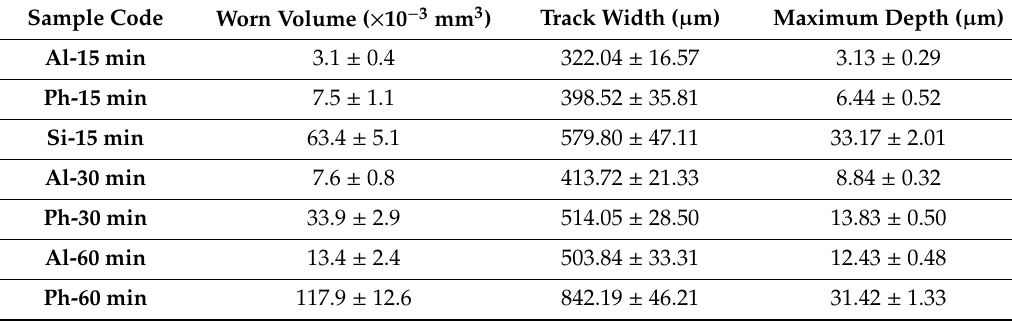
Figure 8. FESEM observation from cross-sections of exposed specimens after detachment from the corrosion cell; ( a ) Al coating after 10 days, ( b ) Ph coating after 9 days, and ( c ) Si coating after 6 days. Table 5. Wear tracks specifications obtained by analysis of line